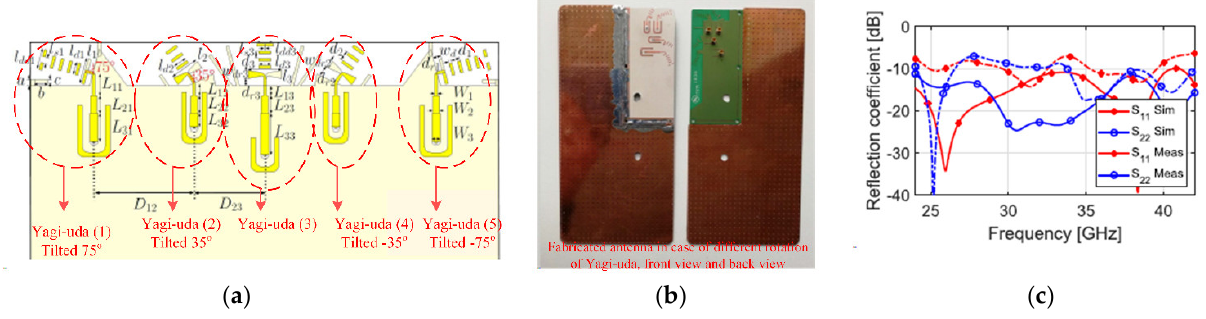
Figure 14. The proposed planar quasi yagi uda antenna in [65]: ( a ) geometry of the proposed an- tenna, ( b ) photo of the fabricated prototype, and ( c ) simulated and measured S parameters.